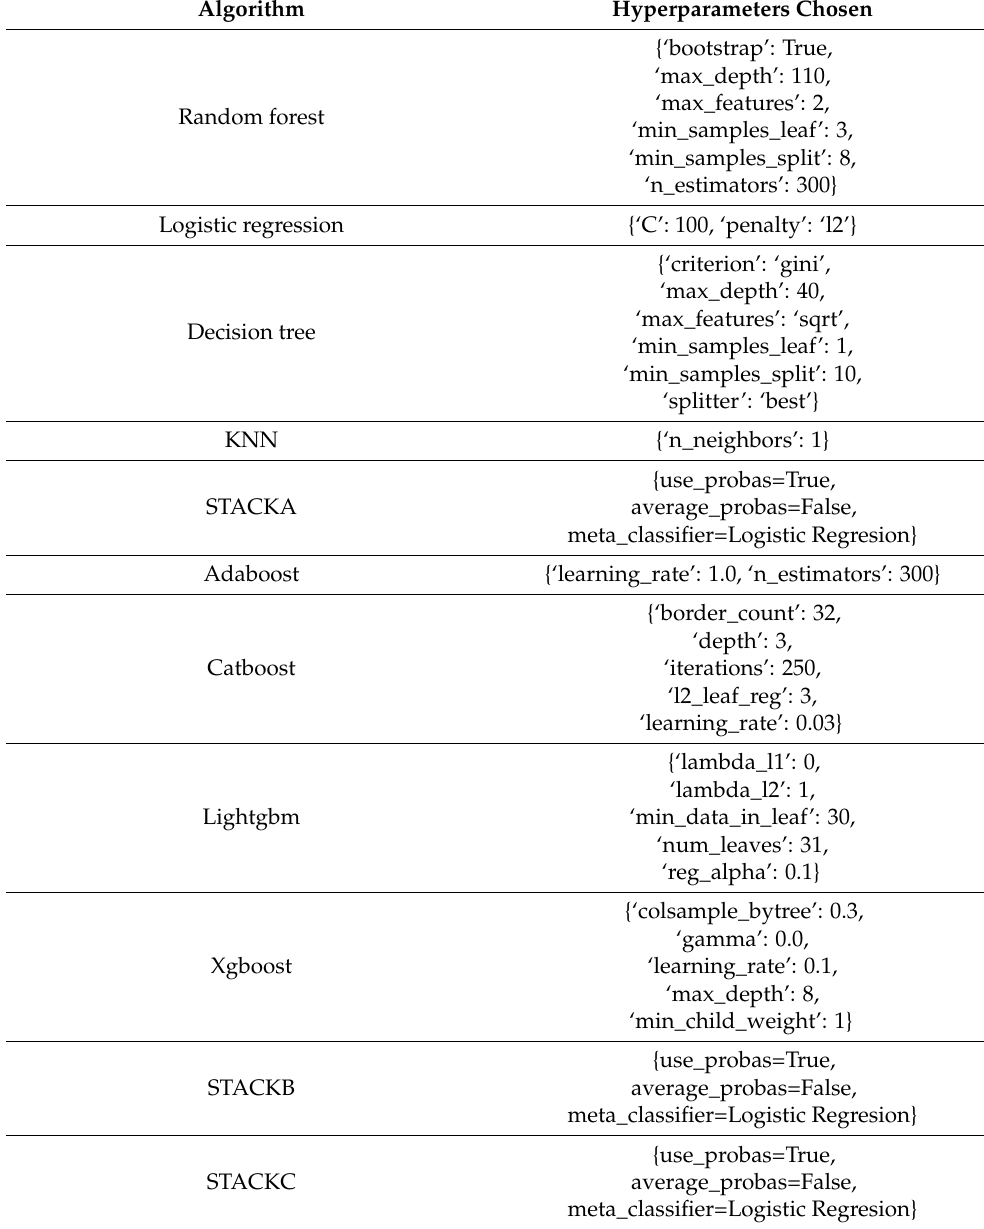
Table 4. Hyperparameters chosen by the algorithms.